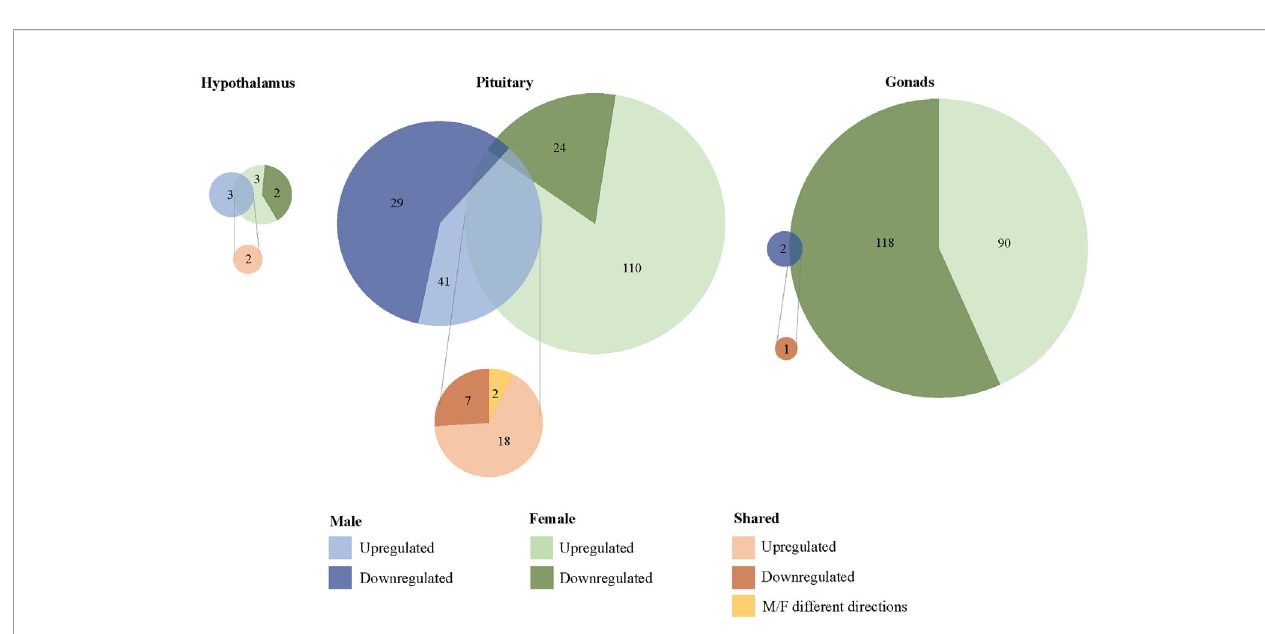
FIGURE 3 | Sex-biased differential transcriptomic expression in response to exogenous CORT treatment. A weighted Venn diagram depicting the overlap of the number of differentially expressed genes between the sexes in the hypothalamus, pituitary, and gonads in response to CORT as compared to vehicle. Genes that upregulated in expression in response to CORT are depicted by a lighter shade; genes that down-regulated in response are depicted by a dark shade. Numbers within shaded areas indicate the number of CORT-responsive